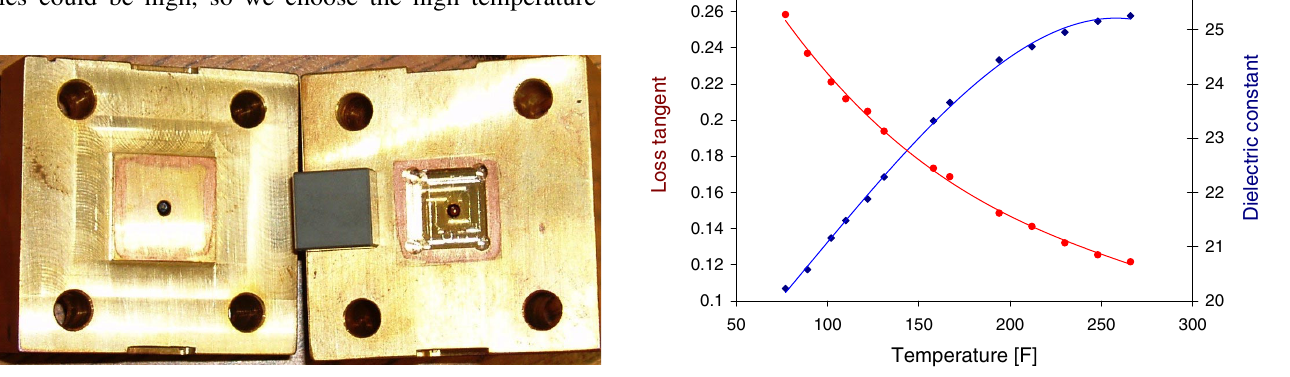
FIG. 10. (Color) Temperature dependence of the dielectric con- stant (blue) and loss tangent (red) from our